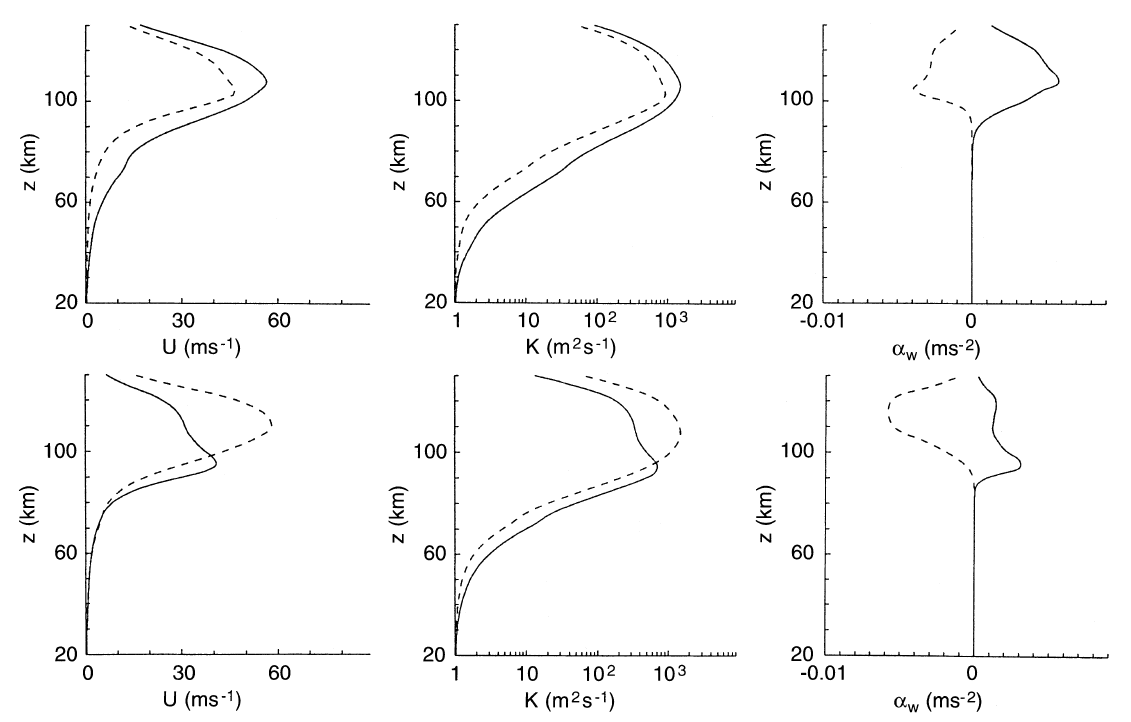
Fig. 6. Same as Fig. 4, but for IGWs with j c j (cid:136) 100m s (cid:255)